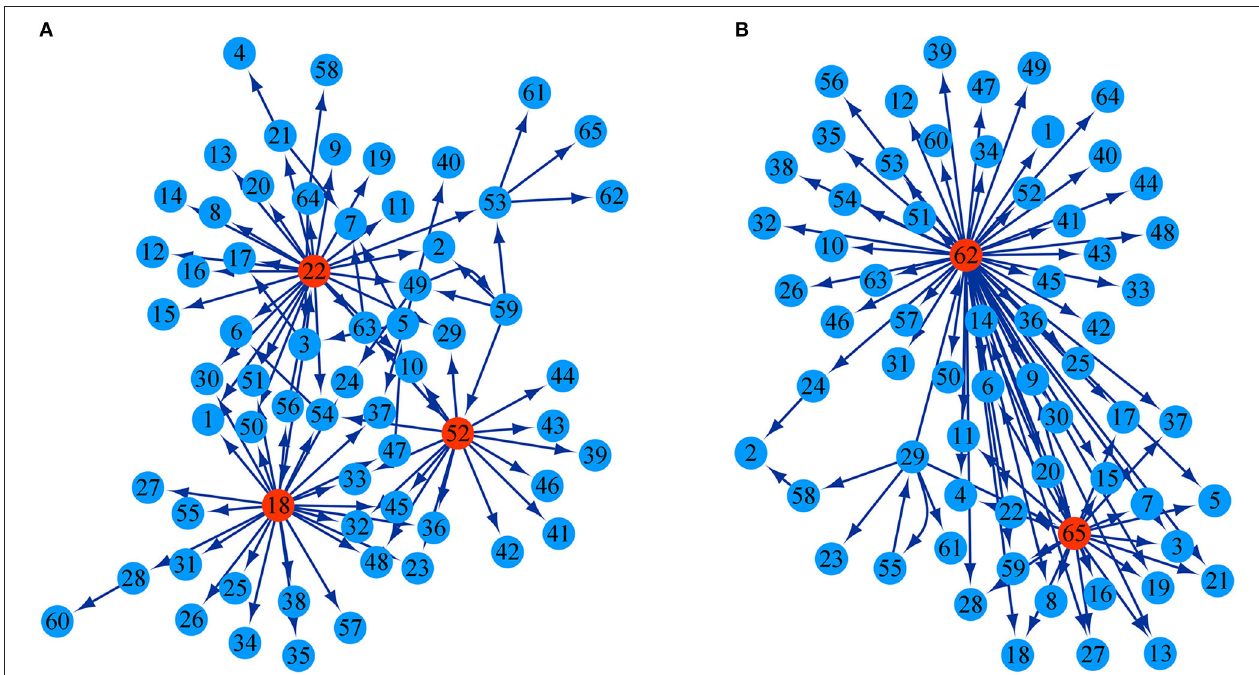
FIGURE 4 | Genetic regulatory networks are generated through genetic effects. (A) Genetic network of 65 significant SNPs with respect to the growth trajectory of stem height. (B) Genetic network of 65 significant SNPs with respect to the growth trajectory of stem diameter. The arrow indicates the direction in which one SNP activates or inhibits another SNP. Highlight circles represent the key QTLs.